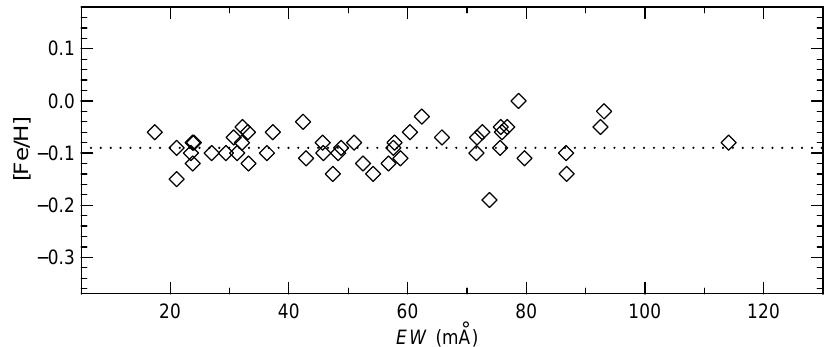
Fig. 3. The [Fe i /H] abundance values versus the equivalent widths. The mean abundance ([Fe i /H] = –0.09 dex) is shown as a dotted